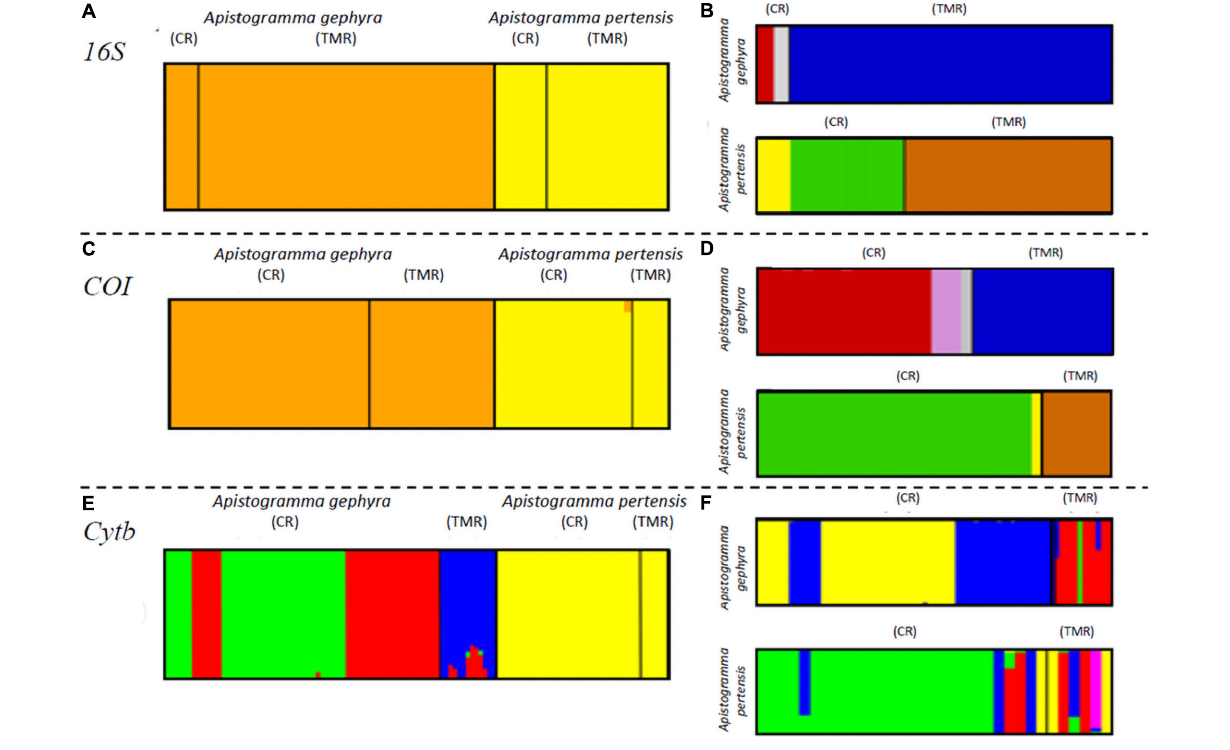
FIGURE 3 | Bayesian analysis of population structure (BAPS). (A,C,E) Refer to Apistogramma gephyra and Apistogramma pertensis from the Cuieiras River (CR) and Tarumã-mirim River (TMR) Rivers presenting, respectively, 16S, COI and Cytb mitochondrial genes; (B,D,F) refer to both species analyzed separately between rivers using, respectively, the genes 16S, COI, and